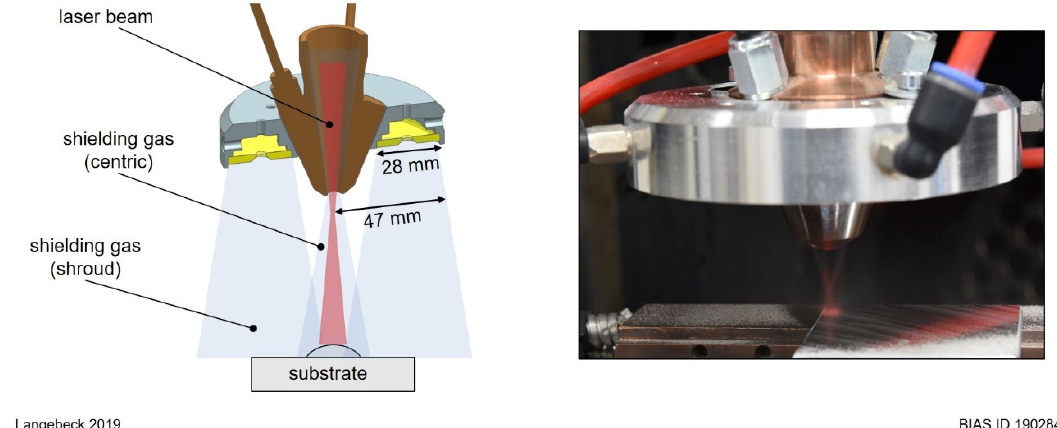
Figure 1. Improved shielding gas concept with an additional shielding gas shroud.